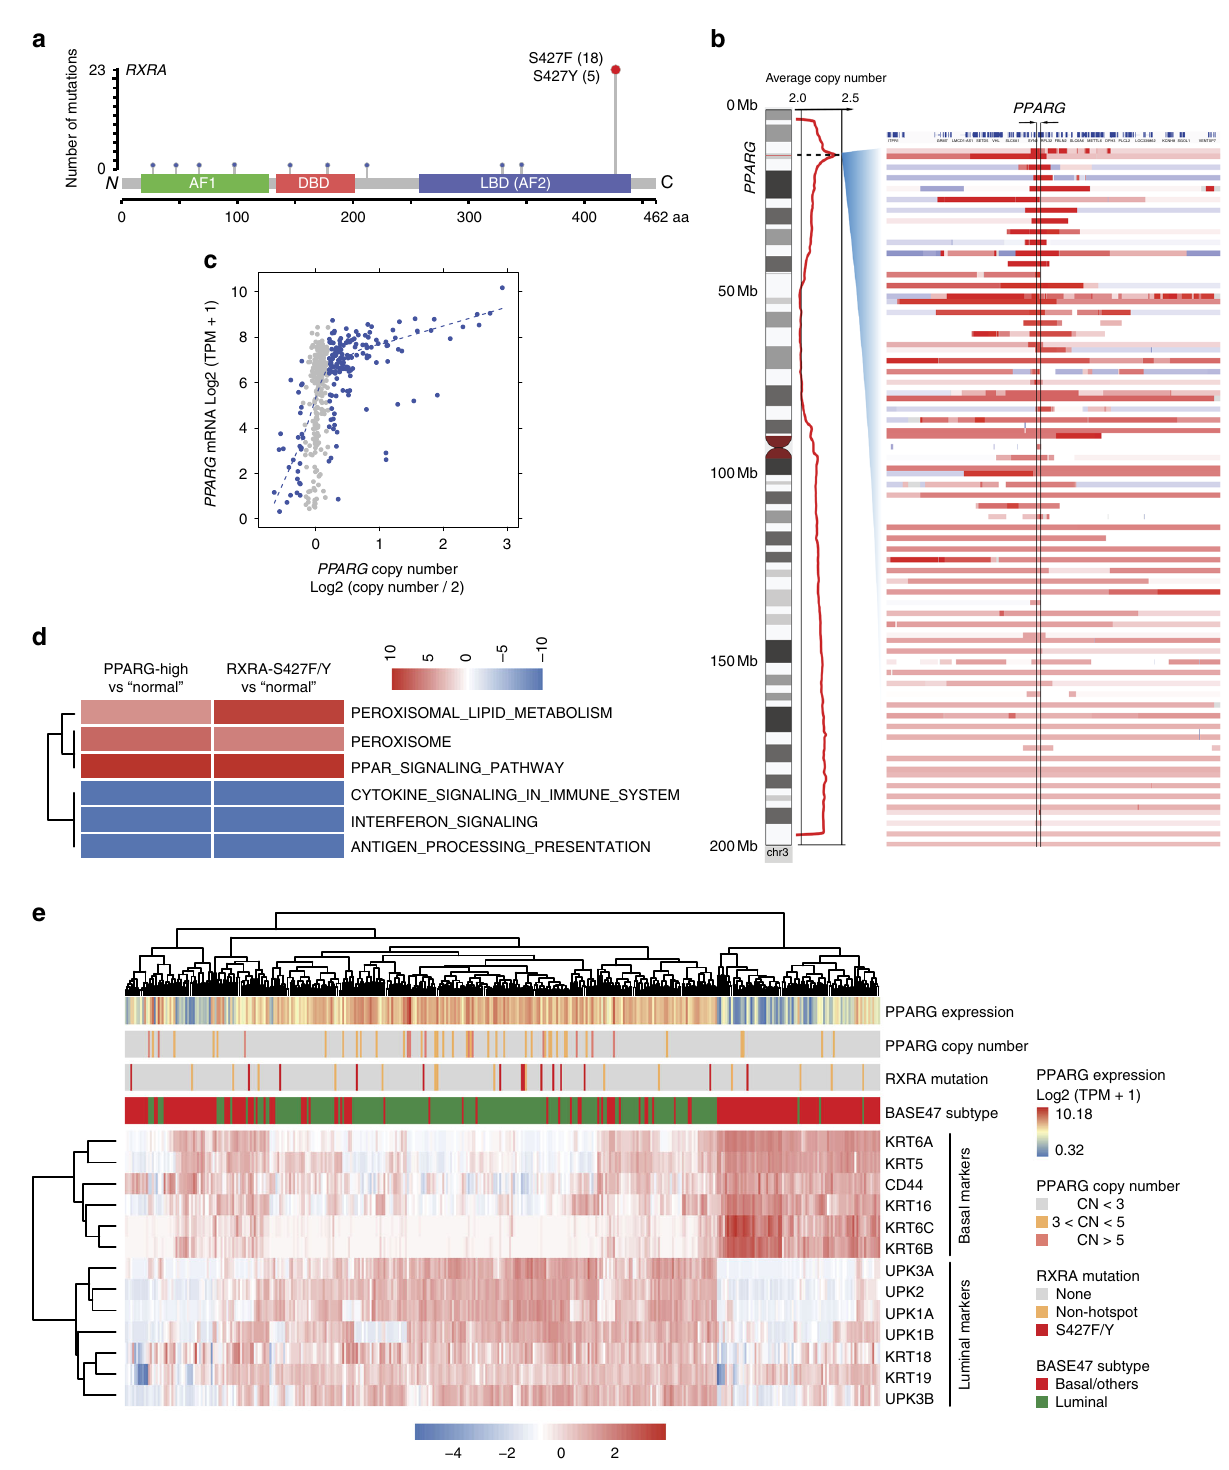
Fig. 1 Recurrent genomic alterations of RXRA and PPARG in bladder cancer. a Hotspot S427F/Y mutations of RXRA in TCGA muscle-invasive bladder cancer ( MIBC ) cohort, BGI/Shenzhen bladder cancer cohort and DFCI/MSKCC bladder cancer cohort ( n = 534). b Focal ampli fi cation of PPARG in TCGA MIBC. c Correlation of copy number ( CN ) and mRNA expression of PPARG in TCGA MIBC ( P < 2.2e − 16). Gray dots represent those samples without CN changes (2.30 > CN > 1.74). d Pathway enrichment analysis of RXRA-S427F/Y and PPARG-high in bladder cancer relative to “ normal ” RXRA-WT and non- hotspot or PPARG-low . e Distribution of PPARG mRNA expression, PPARG copy number variation ( CNV ), and RXRA mutations in subtypes (BASE47 luminal/basal) of TCGA bladder cancer ( n = 385). Statistical analysis was performed using Fisher ’ s exact test and P < 0.05 was considered as statistically signi fi